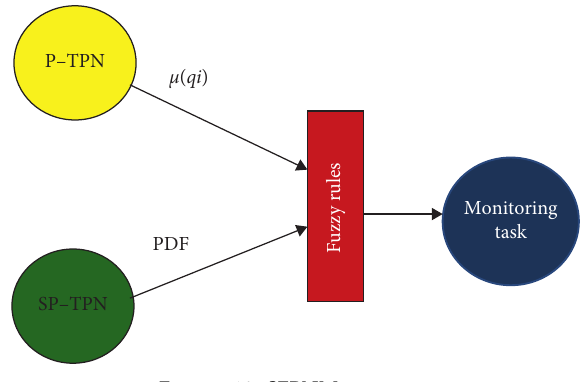
Figure 12: SFPNM